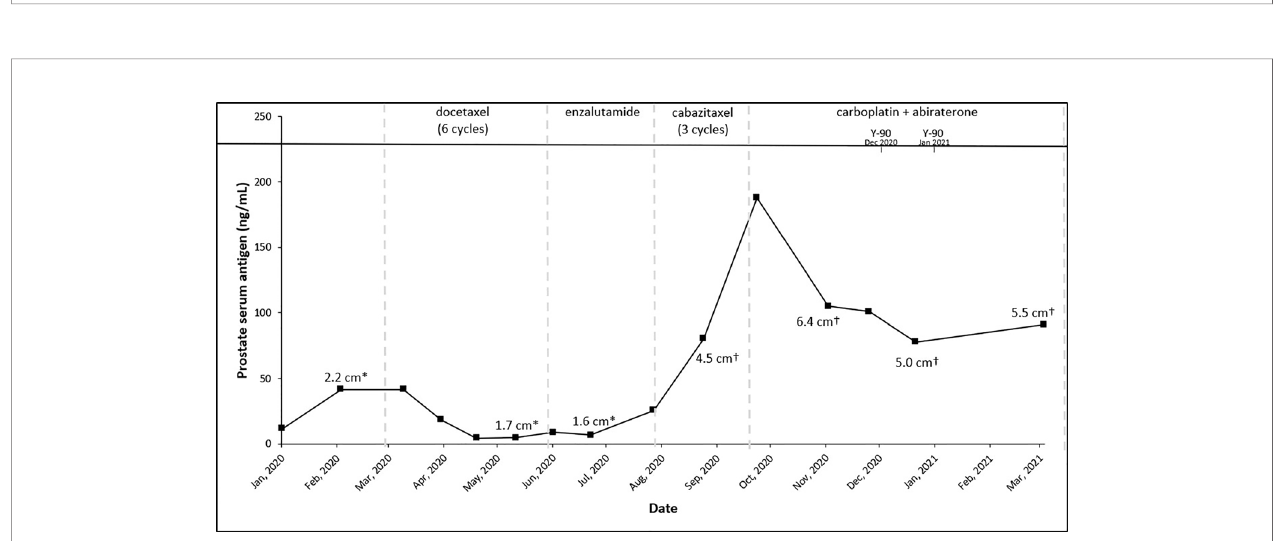
FIGURE 2 | Trends of treatment, prostate serum antigen, and tumor size across patient ’ s treatment course. *Right inferior lobe lesion and † segment 7